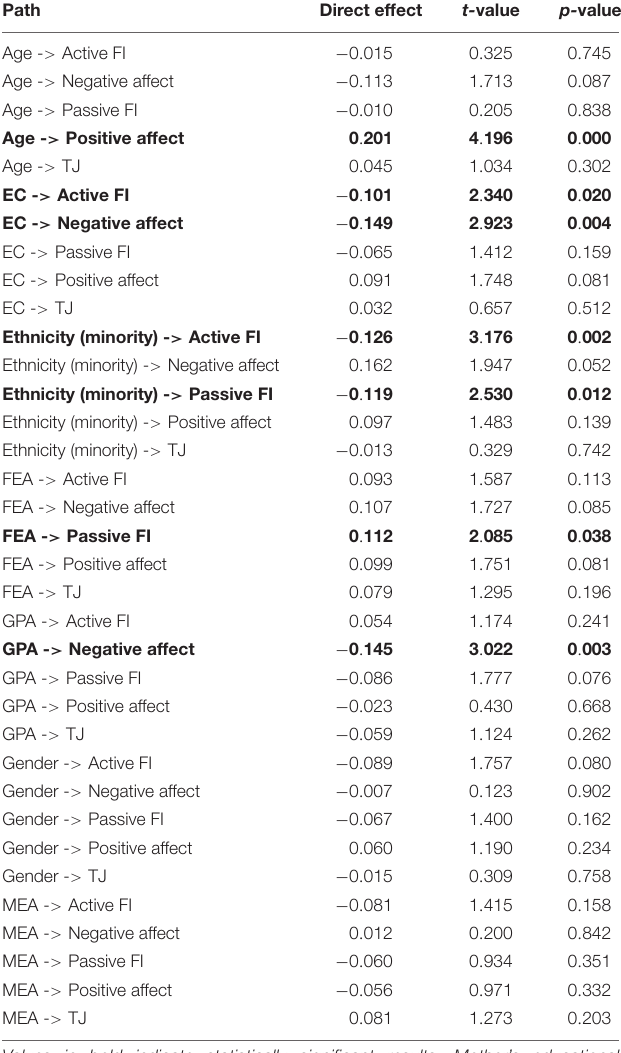
TABLE 3 | Significance analysis of the direct and effects of background variables on research constructs.